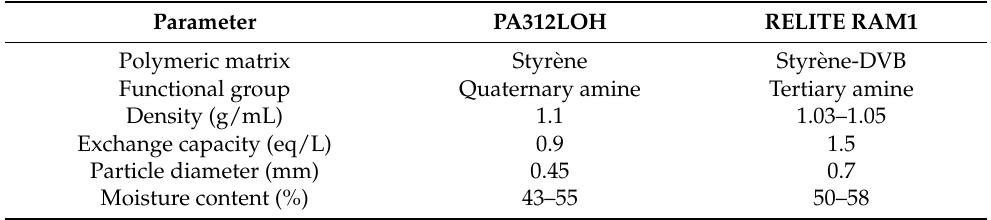
Table 1. Physical properties of the macroporous ion-exchange resins used. Parameter